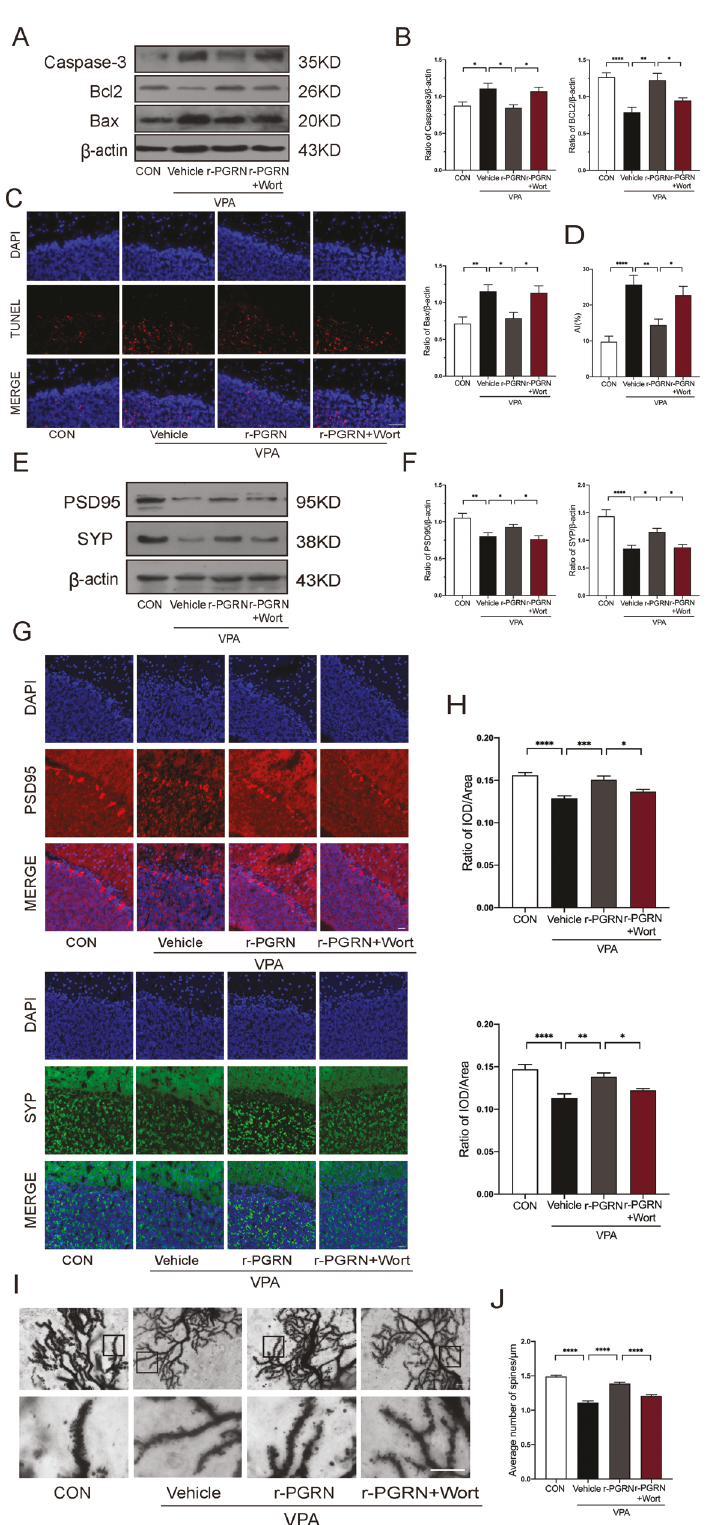
Fig. 5 r-PGRN reduced neuronal apoptosis and improved synaptic development, while PI3K inhibitor wortmannin reversed this effect in VPA-induced rats. Representative blots ( A ) and quanti fi cation ( B ) of Caspase-3, BCL-2, and Bax in the four groups. C , D Representative images (bar = 50 μ m) and quanti fi cation of TUNEL staining. Representative blots ( E ) and quanti fi cation ( F ) of synaptic markers such as PSD95 and SYP. G , H Immuno fl uorescence staining (bar = 25 μ m) exhibited consistent changes in PSD95 and SYP protein expressions. Representative images of Purkinje cell dendrites ( I ) that were used for quanti fi cation of spines (bar = 10 μ m) and quanti fi cation ( J ) of the number of spines. Data are expressed as mean ± SEM. One-way ANOVA followed by Tukey ’ s post hoc (B (Caspase-3, Bax) , D, F (SYP) , H ); post hoc Kruskal – Wallis test for multiple comparisons (B (Bcl2) , F (PSD95) , J ). (* P < 0.05, ** P < 0.01, *** P < 0.001, **** P < 0.0001, sample sizes ( n ): n = 5/group).